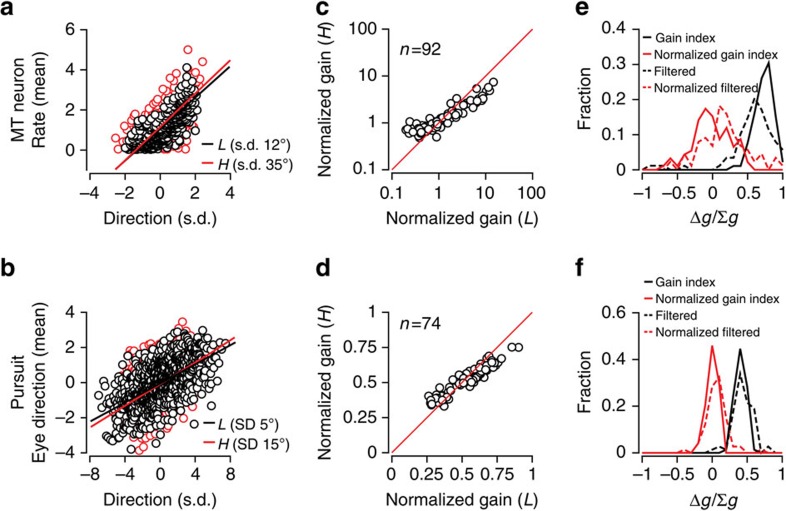
Adaptation normalizes response gain across variance conditions.(a) Plotting the stimulus in units of its s.d., the neuron's input–output relationship is the same for both variances (same data as Fig. 2a). (b) Rescaled input–output data from the same pursuit experiment. (c) MT population data, showing linear gain (red and black lines, a,b) recomputed for the normalized data (L: 2.2±2.9; H: 1.5±1.3, not significantly different, two-sided Wilcoxon rank-sum test, P=0.35, n=92). (d) Pursuit population data similar to c (L: 0.53±0.16; H: 0.52±0.10, not significantly different, two-sided Wilcoxon rank-sum test, P=0.61, n=74). (e) To analyse gain changes across the population, we defined a gain difference index (see text), Δg/Σg, where an index of 0 indicates perfect rescaling. We plot the distribution of MT neuron gain indices before (black solid line; pop mean±s.d.: 0.72±0.13, n=92, significantly different from 0, one-sample t-test, two-tailed, P<10−30) and after normalization (grey solid line; 0.01±0.26, n=92, not significantly different from 0, one-sample t-test, two-tailed, P=0.67). Low-pass-filtered motion stimuli (see text) yielded similar results (dashed lines). (f) Pursuit population data as in e: original data (black solid line, mean±s.d.: 0.40±0.08, n=74, 3 monkeys, significantly different from 0, one-sample t-test, two-tailed, P<10−30) and the rescaled input–output relationship (grey solid line, mean±s.d.: 0±0.07, n=74, 3 monkeys, not significantly different from 0, one-sample t-test, two-tailed, P=0.68). Low-pass-filtered stimuli again yielded similar results (dashed lines).